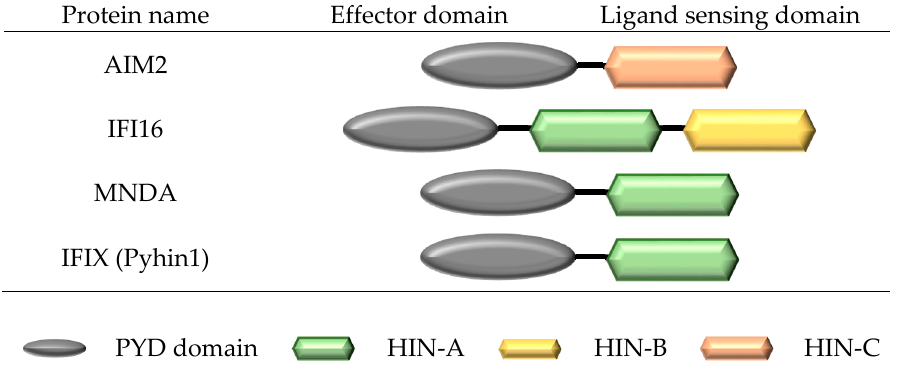
Figure 4. Structure of the human pyrin and hematopoitic interferon-inducible nuclear protein (HIN) domain (PYHIN) family.